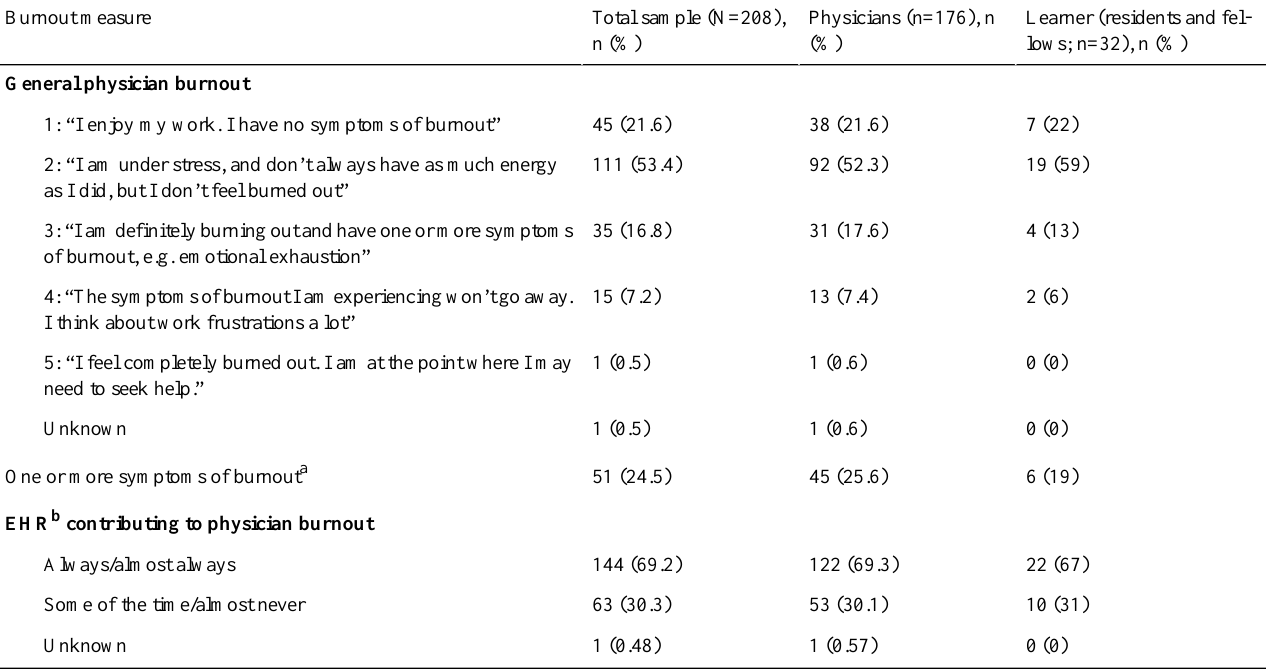
Table 3. Burnout prevalence, by experience level.